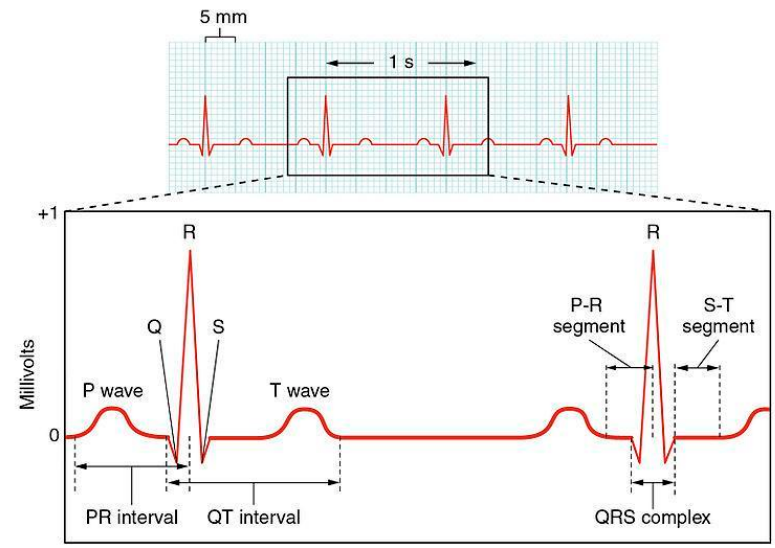
Figure 1. Tracing of a normal electrocardiogram (ECG) including P wave, QRS complex, and T wave. Reproduced with permission from Gordon Betts et al., Anatomy and Physiology, Connexions Website. http://cnx.org/content/col11496/1.6/; published by OpenStax, 19 June 2013.